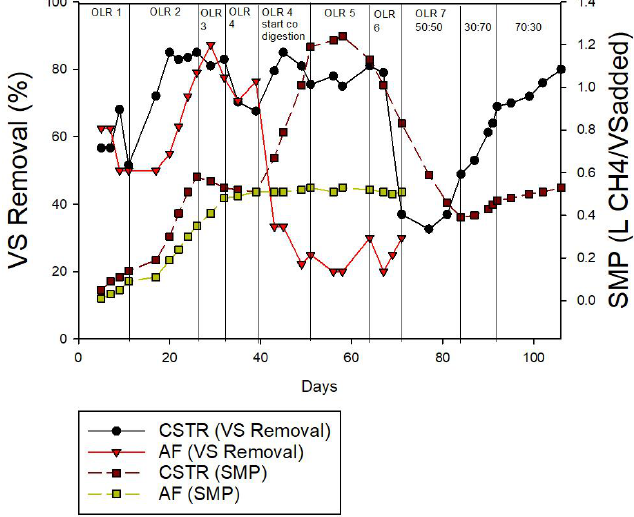
Figure 7. Volatile solids (VS) removal and specific methane production (SMP) for continuous study.